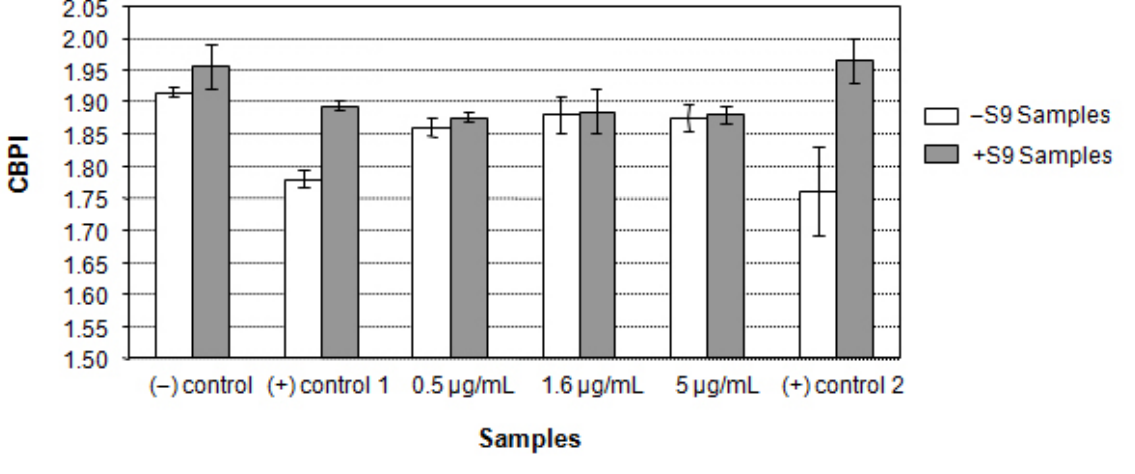
Figure 2. Micronucleus test (CHO-K1 line) and cytokinesis-block proliferation index (CBPI, average number of cell divisions per cell of the slides of the two wells ±SD). Values obtained from the samples in the presence (+) and absence ( - ) of metabolic activation (S9). The ( - ) control corresponds to the culture medium of each sample; (+) control 1 employed mitomycin C and benzopyrene in - and + S9 samples for metabolic activation, respectively; (+) control 2 is related to colchicine in the - S9 samples and to cyclophosphamide for the +S9 samples. CHO: Chinese hamster